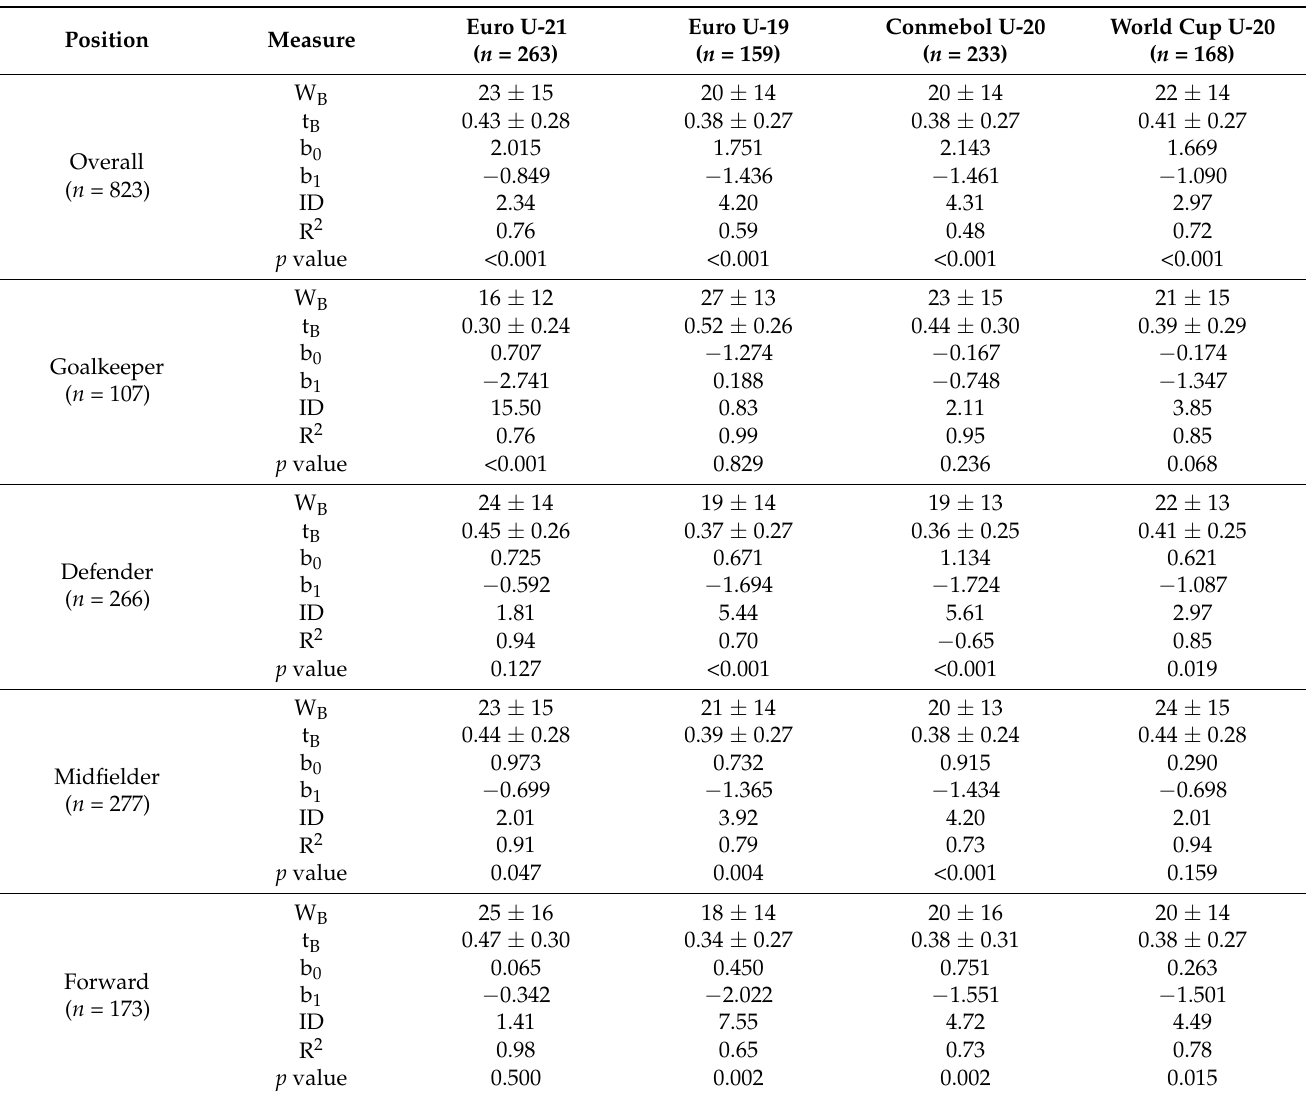
Figure 1. Quartile of birth of players by championship. Table 2. RAE data analysis by position and